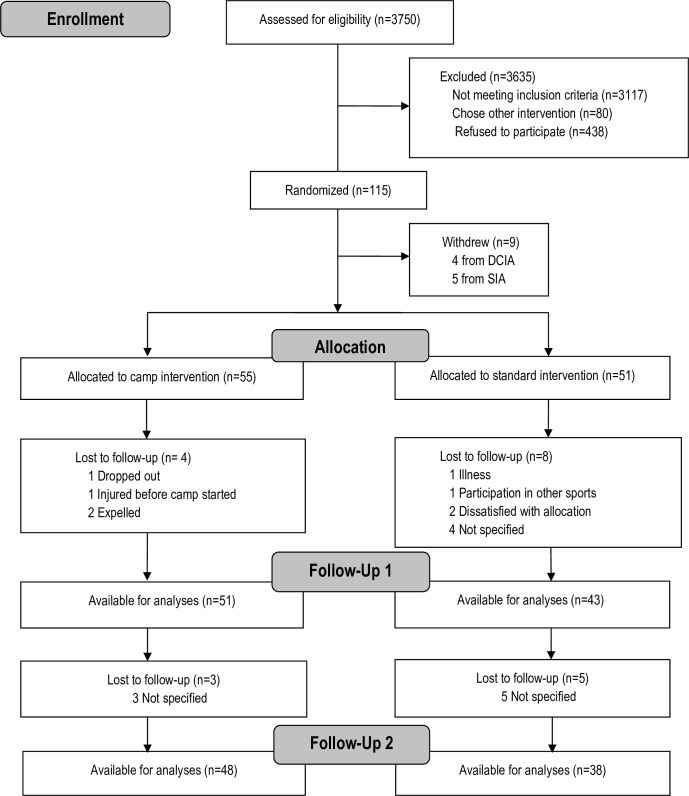
Flow of participants.